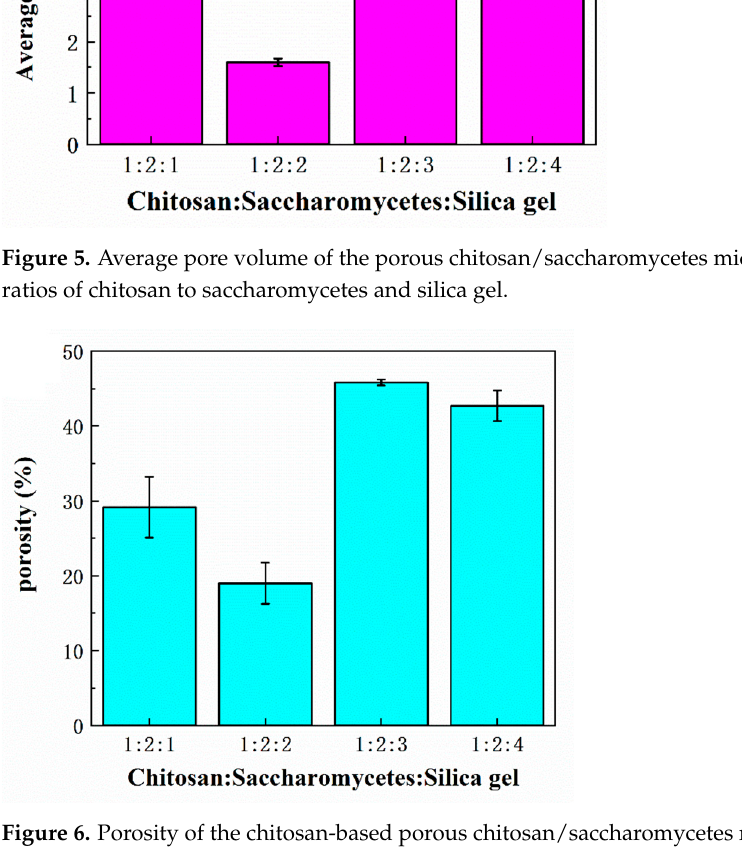
Figure 6. Porosity of the chitosan-based porous chitosan/saccharomycetes microspheres with different ratio of chitosan to saccharomycetes and silica gel.